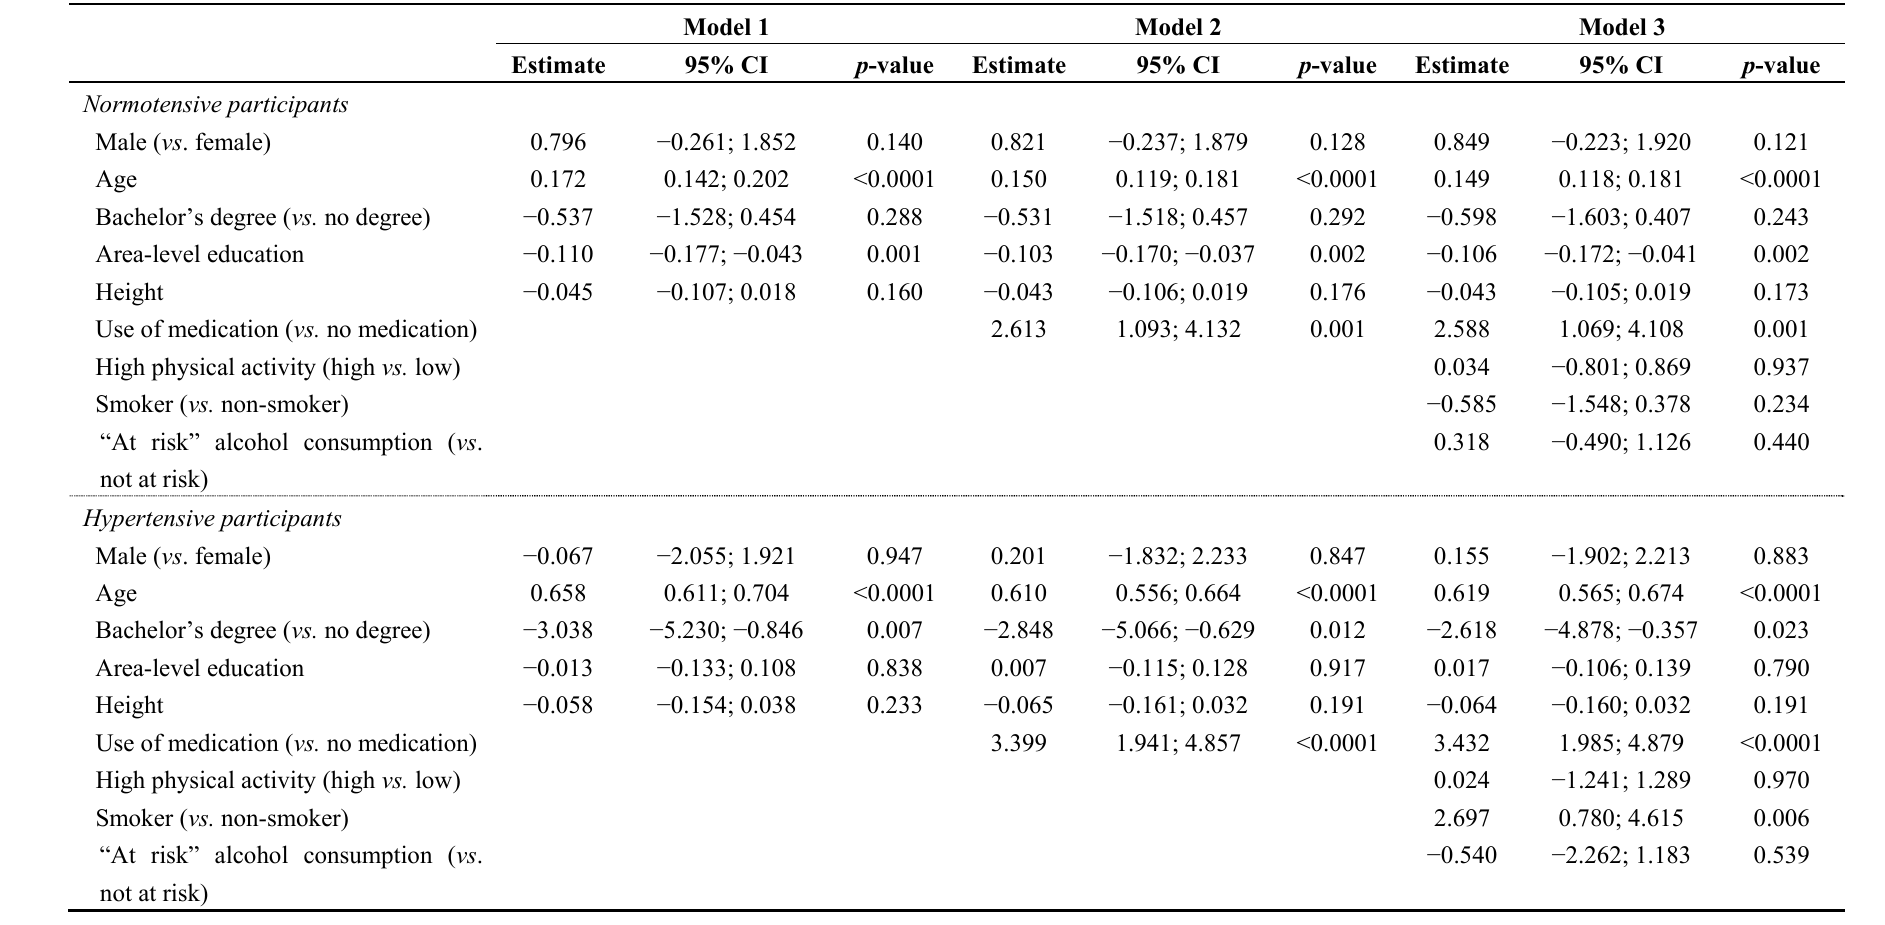
Table 2. Results of models testing the associations between pulse pressure and education attainment, according to hypertensive